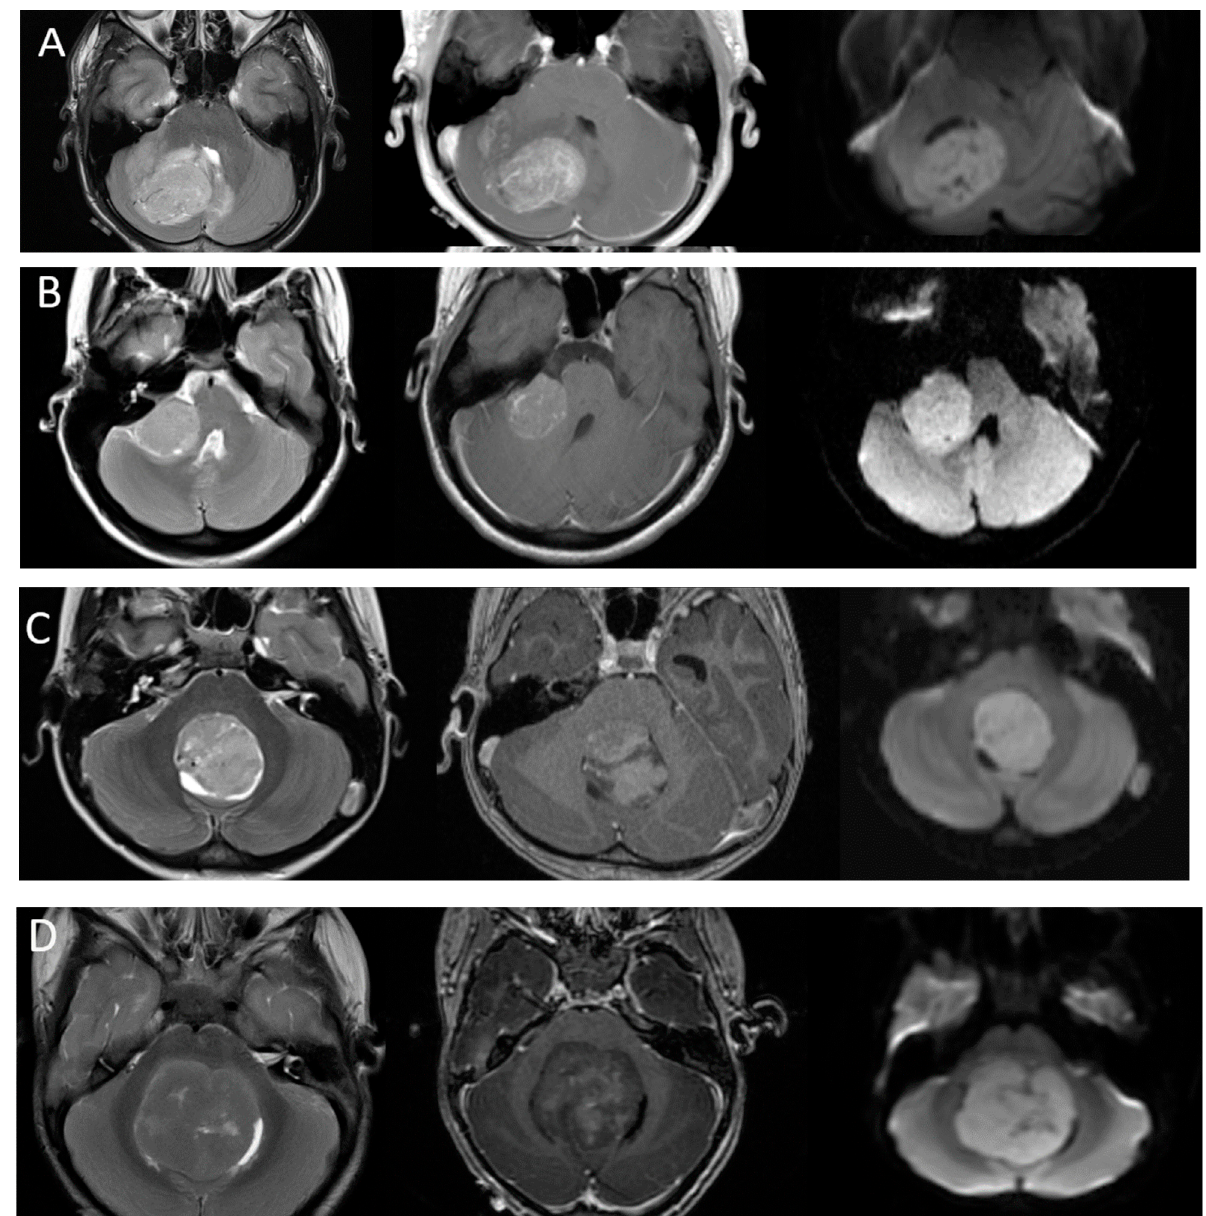
Figure 3. Imaging appearances of molecular subtypes of medulloblastoma. Each row includes axial T2-weighted, axial post-contrast T1-weighted and axial diffusion-weighted images from left to right. (Row ( A )): SHH. Imaging demonstrates an off-midline lesion with the classic cerebellar hemispheric location of these lesions. (Row ( B )): WNT. Imaging demonstrates the classic CP angle location of this subtype, although many of these lesions may arise in the midline as well. (Row ( C )): Group 3 and (Row ( D )): Group 4. These tumors are classically located in the midline. Note the relative hypoenhancement of the group 4 tumor, which has been a described feature. All lesions demonstrate characteristic restricted diffusion.